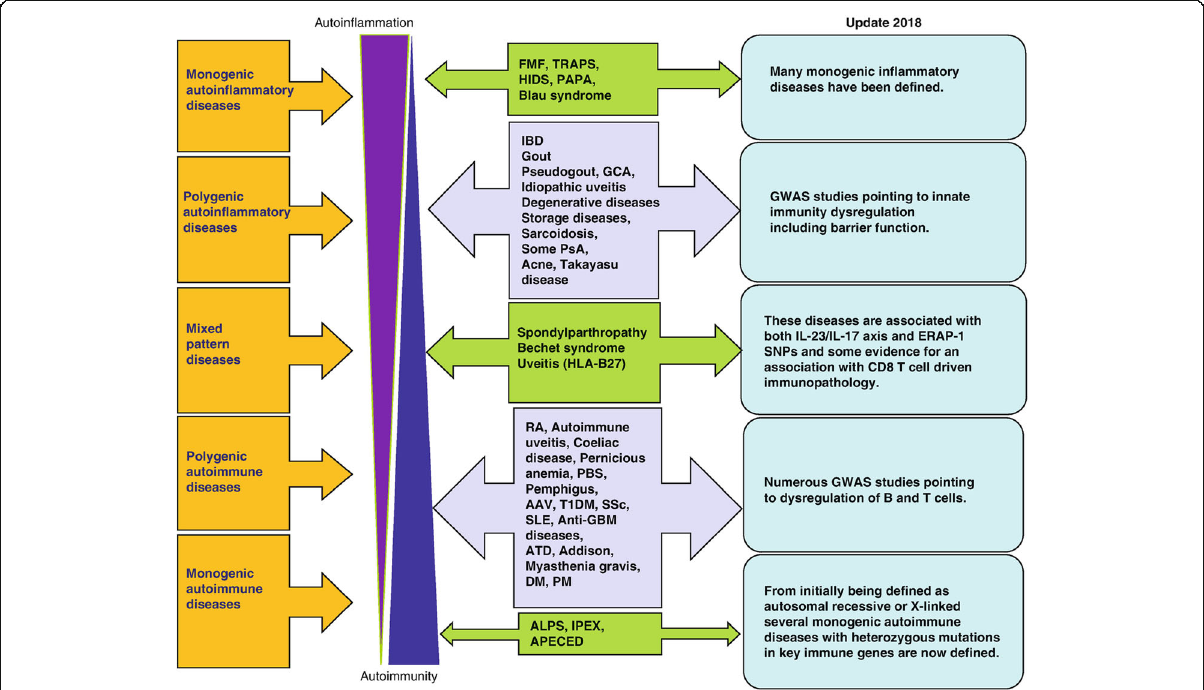
Fig. 1 The immunological disease continuum with pure autoimmunity and pure autoinflammation or innate immunopathology at opposites [14]. FMF familial Mediterranean fever, TRAPS tumor necrosis factor receptor-associated periodic syndrome; HIDS hyperimmunoglobulinemia D syndrome; PAPA pyogenic arthritis pyoderma gangrenosum and acne syndrome; IBD inflammatory bowel disease; GCA giant cell arteritis; PsA psoriatic arthritis; PBS primary biliary cirrhosis; AAV ANCA-associated vasculitis; T1DM type 1 diabetes mellitus; SSc systemic sclerosis; SLE systemic lupus erythematosus; ATD autoimmune thyroid disorder; DM dermatomyositis; PM polymyositis; ALPS autoimmune lympho-proliferative syndrome; IPEX immune dysregulation polyendocrinopathy enteropathy x-linked syndrome; APECED autoimmune polyendocrinopathy-candidiasis-ectodermal dystrophy; GWAS genome-wide association studies; ERAP-1 endoplasmic reticulum aminopeptidase 1; SNP single-nucleotide